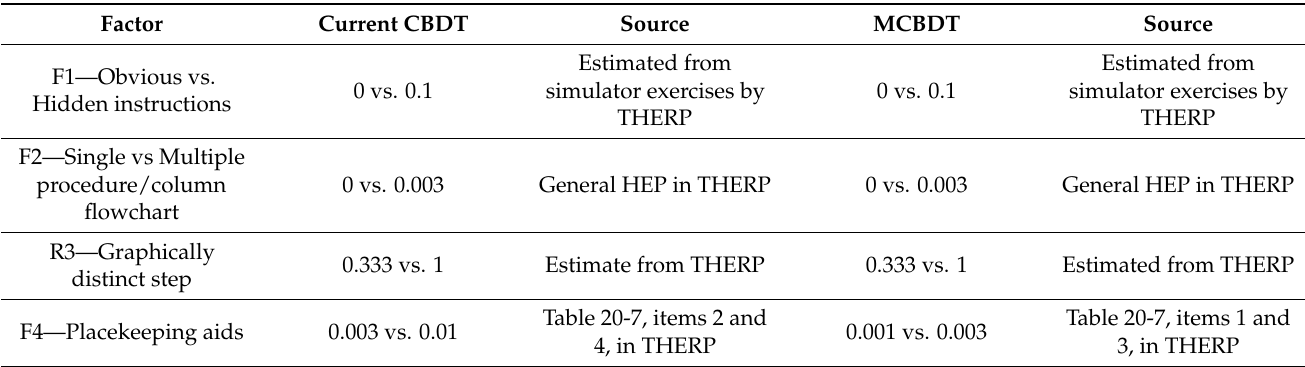
Table 3. Pce evaluation HEPs in MCBDT and their